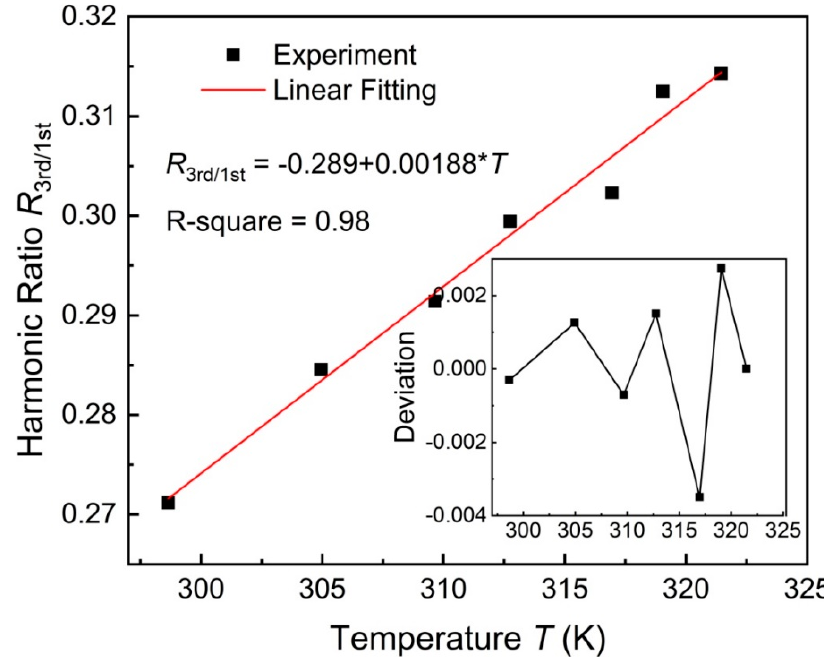
Figure 2. Harmonic ratio R 3rd/1st versus temperature T . The applied AC magnetic field has amplitude of 10 mT and frequency of 2004 Hz. The inset shows the deviation between the experimental and linear fitting harmonic ratios. Symbols represent experimental results whereas solid line is a linear regression curve.